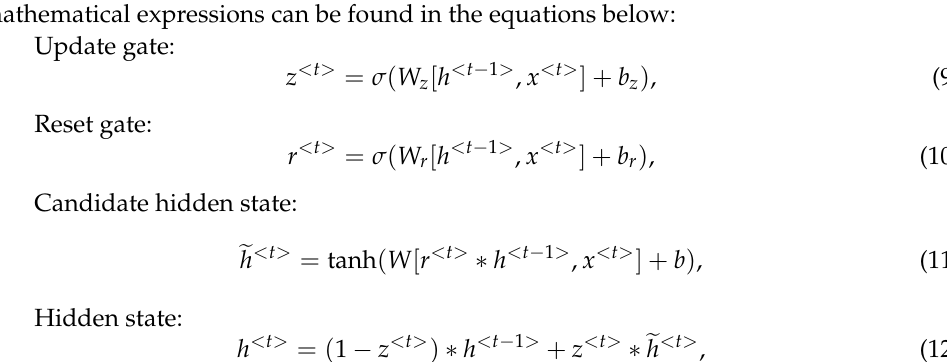
Figure 4. Illustration of gated recurrent unit (GRU) unit, having two gates without dedicated memory cell state.